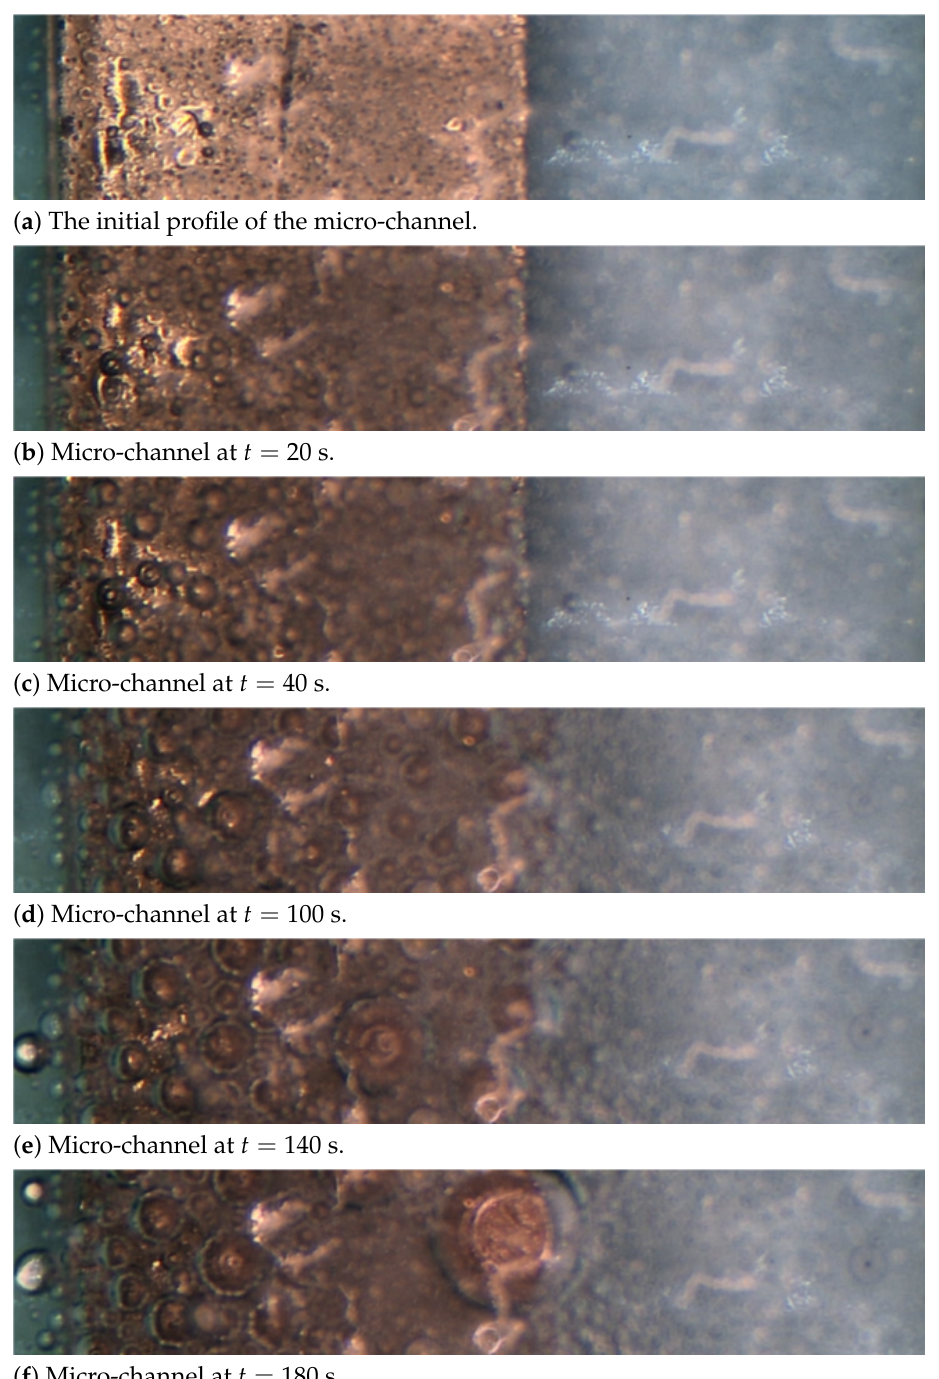
Figure 20. The pictures are taken from the top side and the region near the center between two 8 mm × 1 mm sheet glasses. The brown region is covered by the copper plate, where the surface reaction